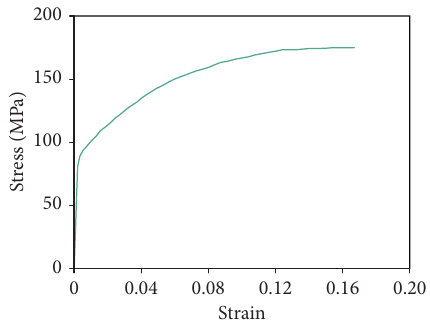
Figure 4: Engineering stress-strain curve of AA6060 T4 [17].